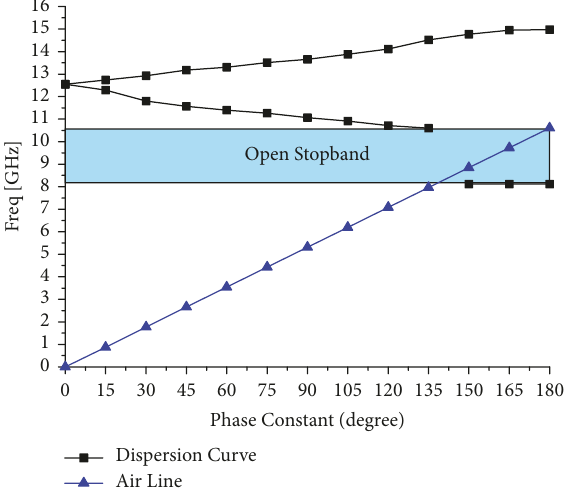
Figure 8: Dispersion curve of antenna radiation unit.